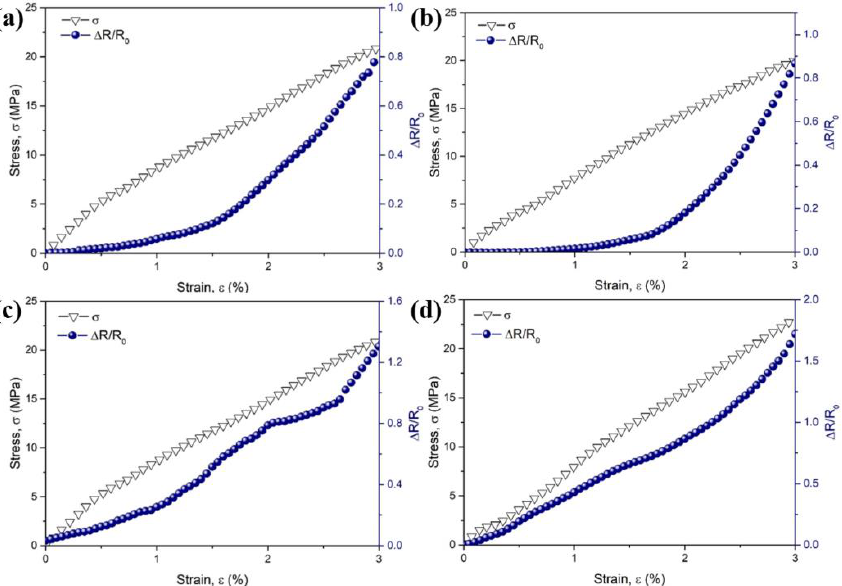
Figure 6. Stress and ΔR/R 0 as a function of tensile strain for CB/PA6/PP composites: ( a ) λ = 1, ( b ) λ = 5, ( c ) λ = 10, ( d ) λ = 15 under the uniaxial tension-strain. ( b ) λ = 5, ( c ) λ = 10, ( d ) λ = 15 under the uniaxial